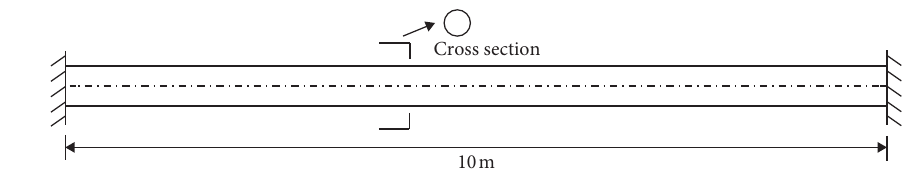
Figure 7: Structure diagram.